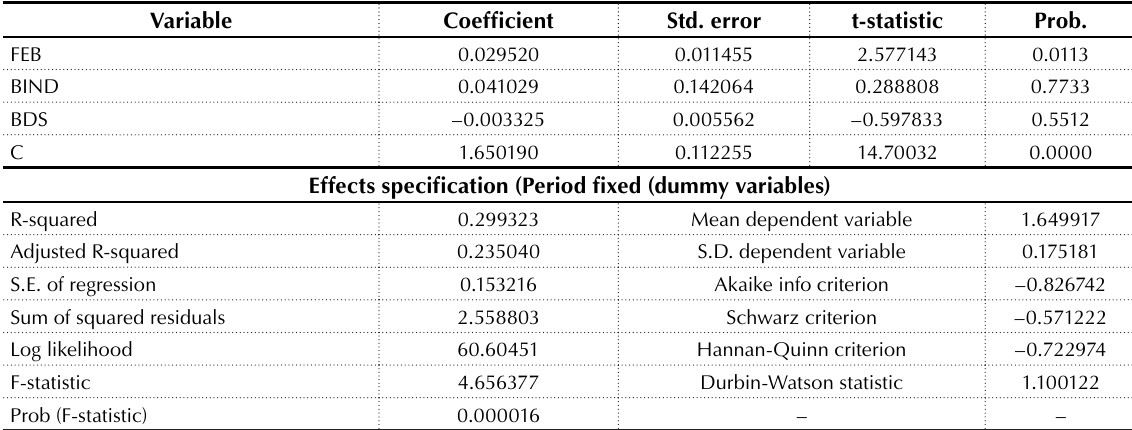
Table 4. Regression result for panel